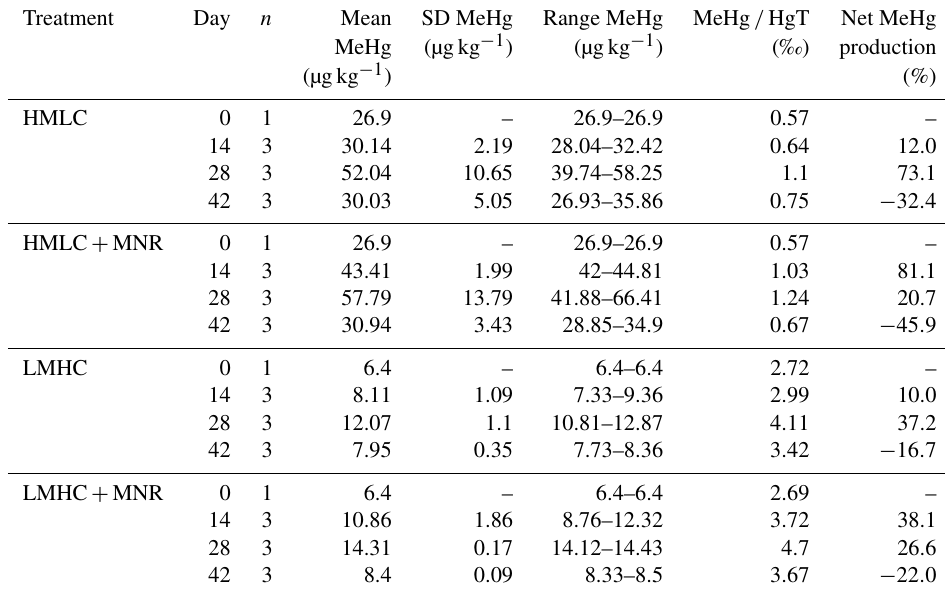
Table 3. Soil MeHg concentrations and net methylation (MeHg / Hg) over the time of the experiment.